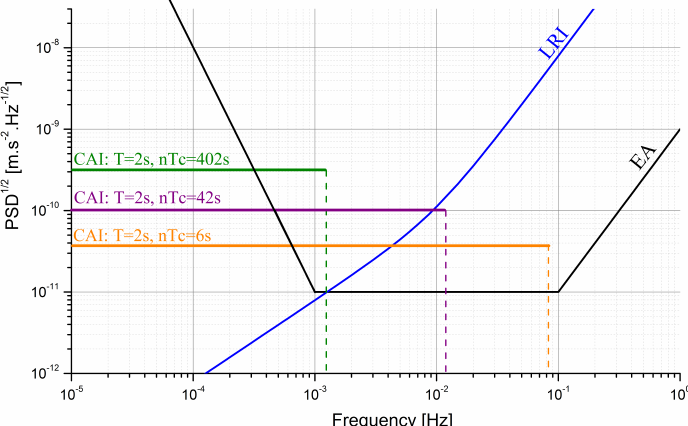
Figure 31. Temporal sequence describing the intermittent mode. The standard mode (up) allows acceleration measurements each T c . In the intermittent mode (bottom), the measurements are now only each n · T c . In this example, we take n = 4. In between, the CAI is put in low power consumption mode (standby mode) allowing lowering the average electrical power consumption.